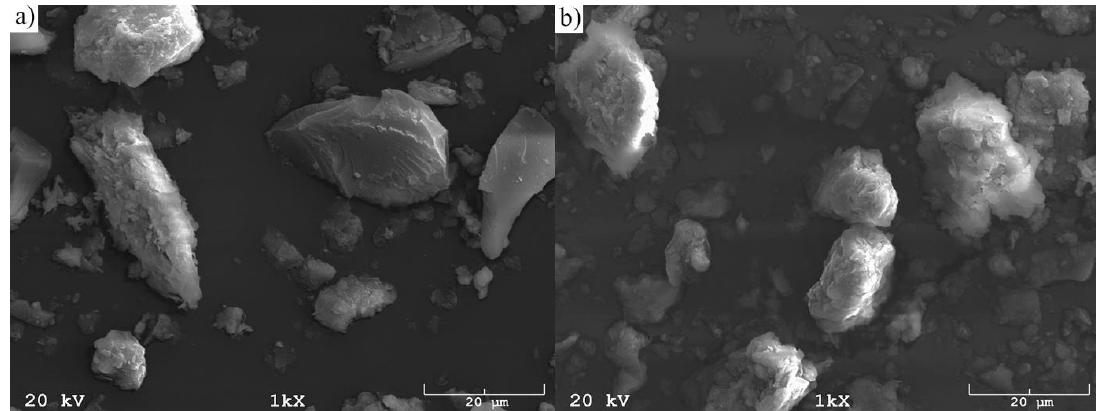
Figure 5. The SEM morphology of coal, depending on the sampling point: ( a ) R1 and ( b ) R2.